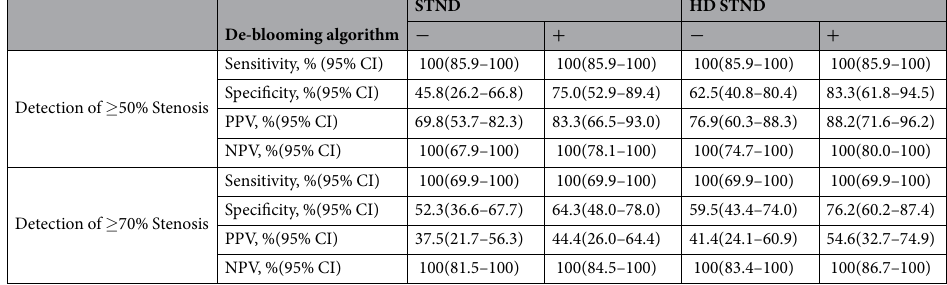
Table 1. Diagnostic Performance of CCTA in calcified plaques PPV, positive predictive value; NPV, negative predictive value; CI, confidence interval; STND: standard mode reconstruction; HD STND: high definition mode